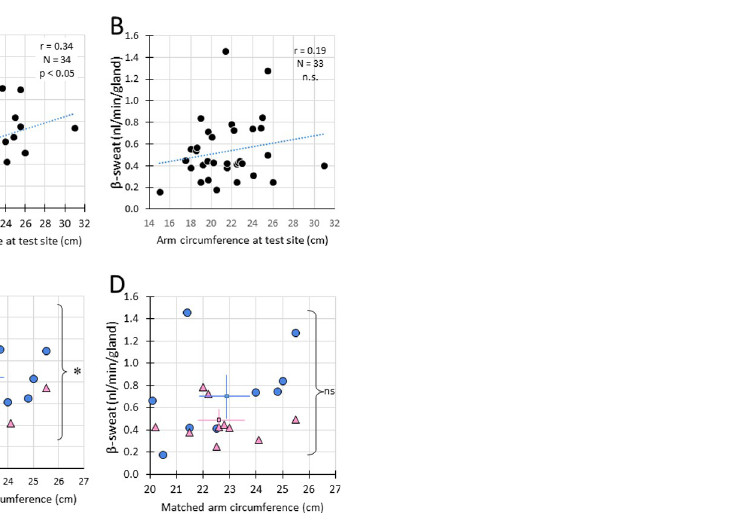
Fig 5. Arm size and sex affect sweat gland M-sweat rates. A . Arm circumference at the test site was positively correlated with M-sweat rates of individual glands (r = 0.34, n = 34, p < 0.05). B . Arm circumference at the test site was positively correlated with C-sweat rates of individual glands but did not reach significance (r = 0.19, n = 33, n.s). C. In a size-matched sample, M-sweat rates of males (blue circles) were significantly greater than females (pink triangles), 2.53 ± 0.67 vs. male: 4.25 ± 1.52, p < 0.01, � indicates p < 0.01. Means and SD indicated. D . In a size-matched sample, β -sweat rates of males (blue circles) were not significantly greater than females (pink triangles): female 0.47 ± 0.17 vs male 0.75 ± 0.41 p = 0.08, ns). Means and SD